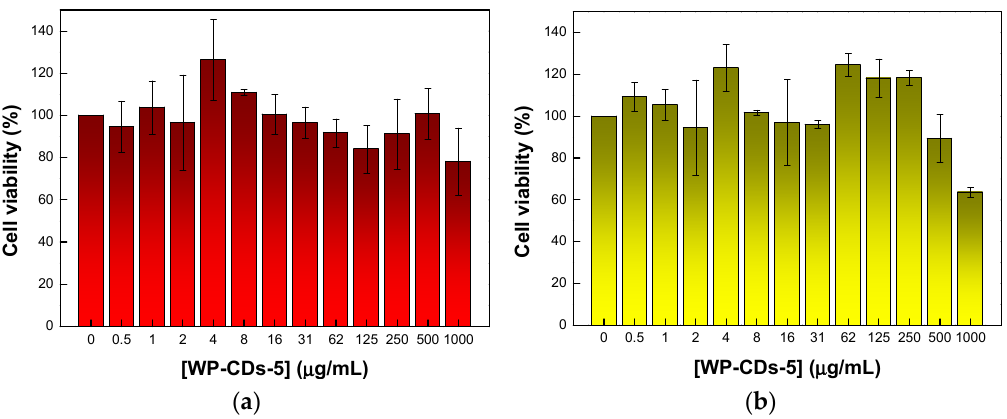
Figure 10. In vitro cytotoxicity results of WP-CDs-5 at various concentrations (0.5–1000 µg/mL) against ( a ) L929 and ( b ) HeLa cells after incubation for 24 h, as evaluated by the resazurin fluorescence viability assay.